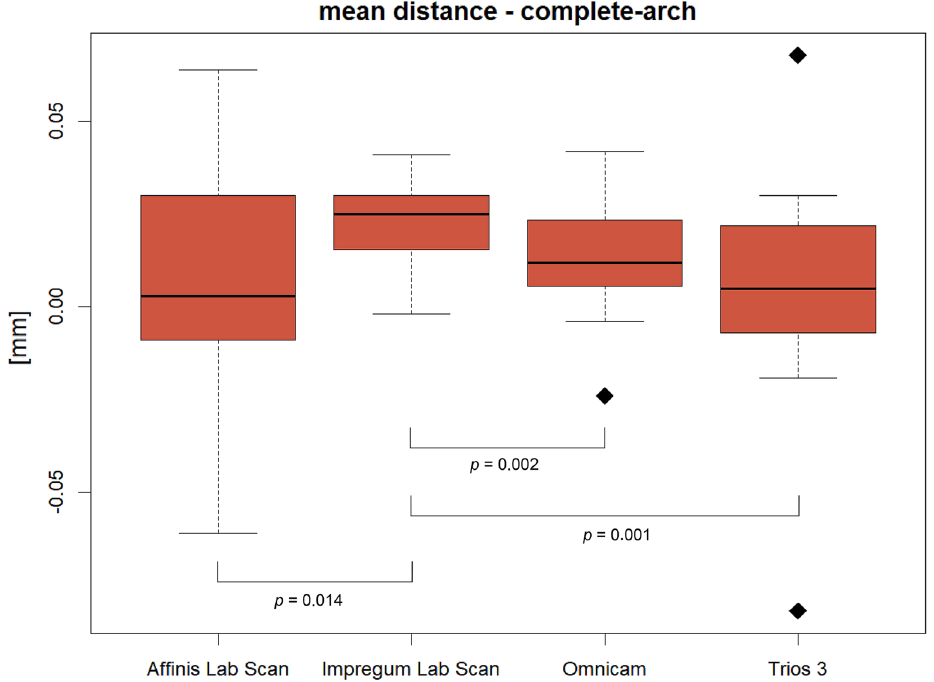
Figure 2. Mean distance for complete-arch (n = 31) and significant p